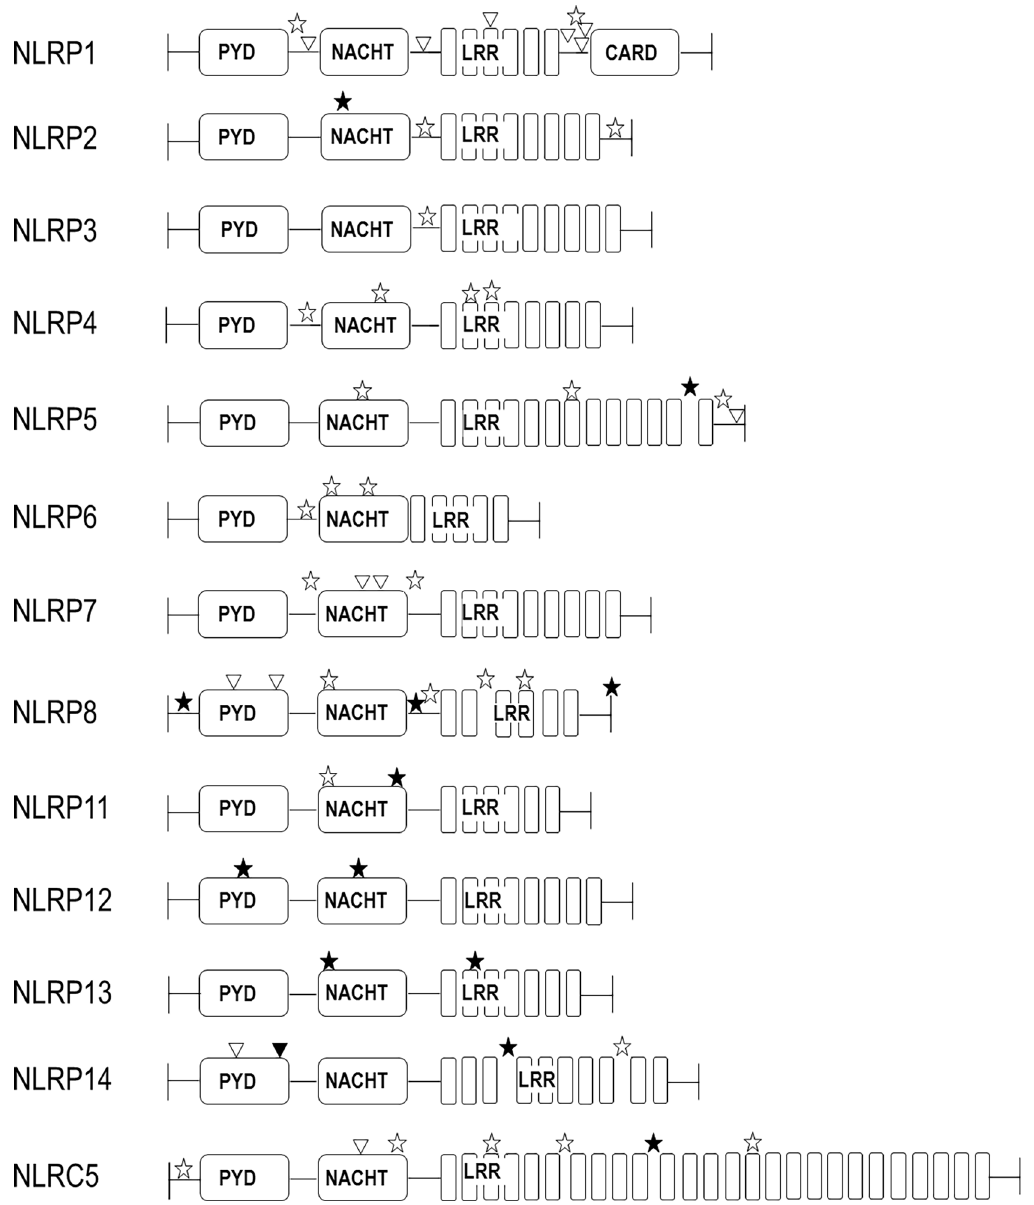
Fig 1. Protein structure of the candidate genes with genotyped SNPs (open and filled star symbols ☆ / $ ), and all linked missense SNPs (triangle 4 ; r 2 (cid:21) 0.8). Filled star ( $ ) and triangle ( ▲ ): SNPs predicted damaging (SIFT) or deleterious